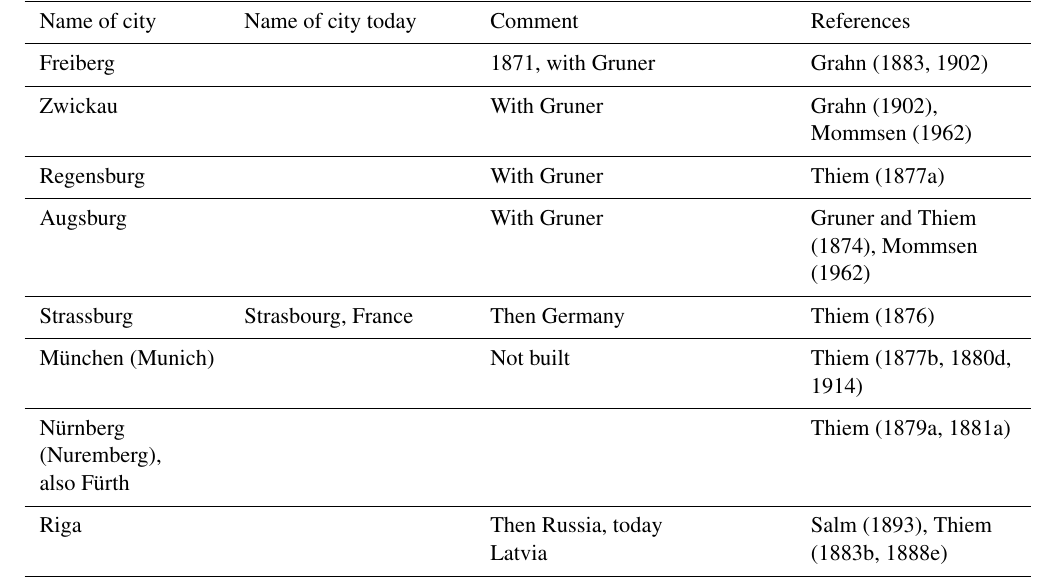
Table 1. Main water supplies planned and built by Adolf Thiem (English names in